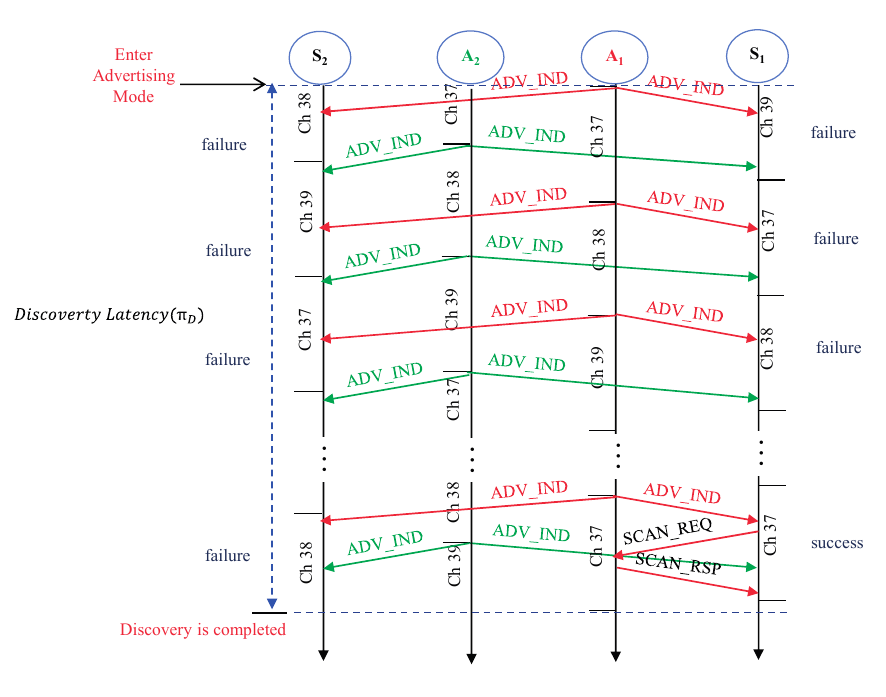
Figure 7. Discovery